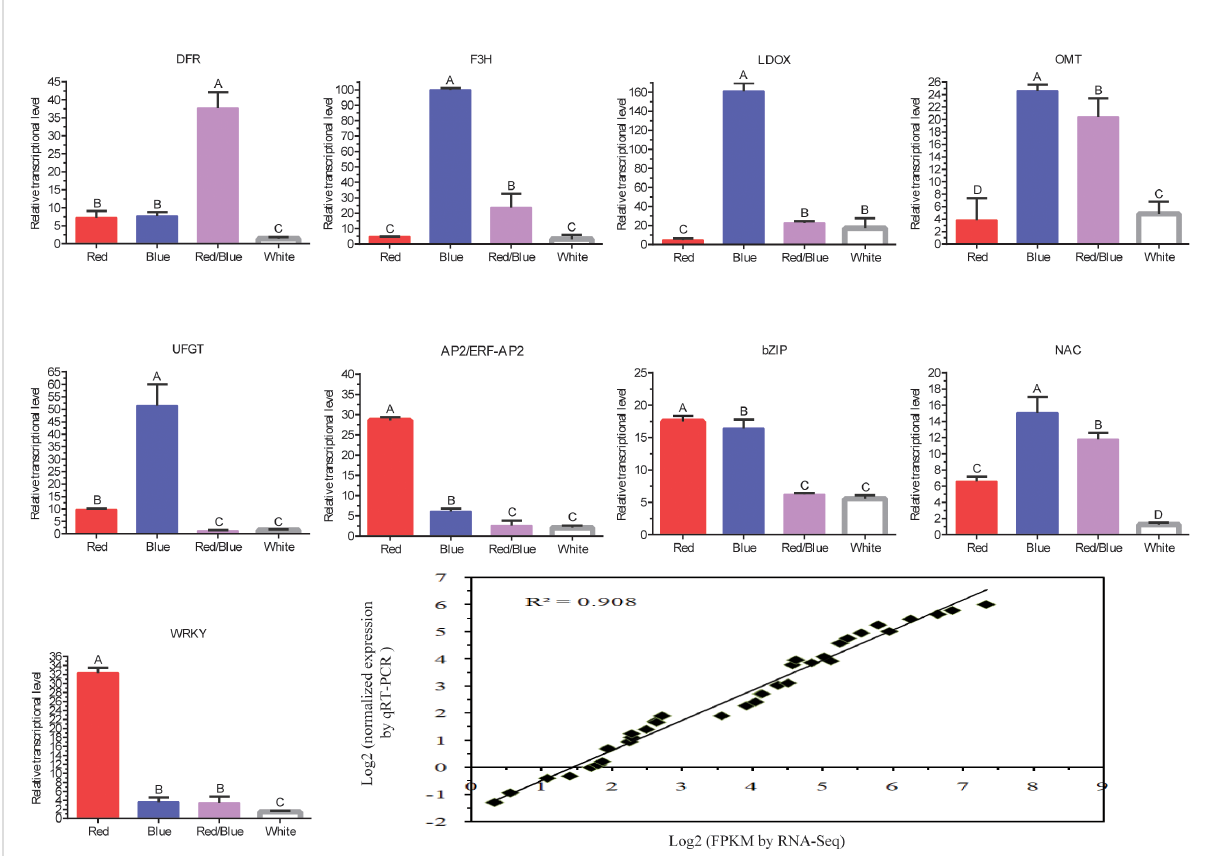
FIGURE 5 Quantitative RT-PCR validation of the structural genes involved in the anthocyanin biosynthesis pathway and transcription factors and the correlation analysis of the gene expression results obtained from the qRT-PCR and RNA-Seq under different light qualities (red, blue, red/blue, and white). The x-axis represents the different light qualities while the y-axis represents the relative expression of each gene. Capital letters indicate signi fi cant differences at P < 0.01 among the different treatments. Error bars represent the standard deviation based on three